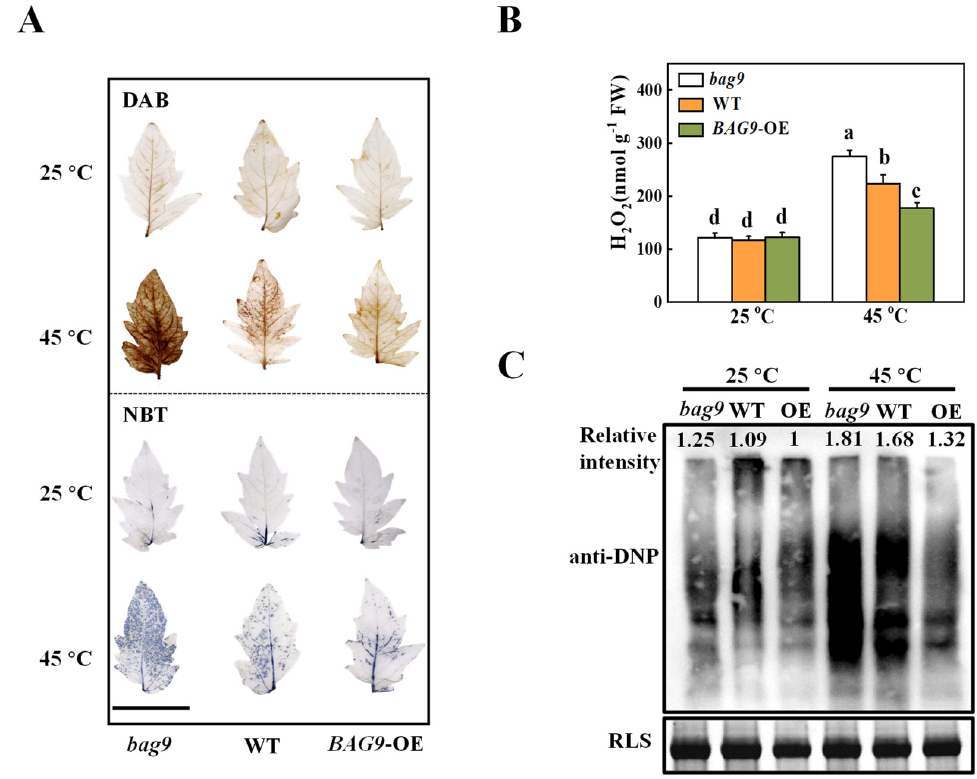
Figure 4. The accumulation of reactive oxygen species (ROS) and oxidative proteins in tomato plants under heat stress. ( A ) Representative images of H 2 O 2 and O 2• − accumulation were detected by DAB and NBT staining, respectively. Bar = 5 cm. ( B ) Quantification of H 2 O 2 at 7 h under heat. ( C ) Oxidative proteins. An anti-DNP antibody was used to detect total proteins on SDS-PAGE. Coomassie Blue staining (CBB) was applied to indicate the protein input, and on the top of the image was the relative intensity of oxidative proteins. Three independent experiments were performed with similar results. Data were the means ±SD of three biological replicates. Different letters represented significant differences ( p < 0.05) according to Tukey’s test. WT, wild type; BAG9 -OE, BAG9 overexpressing plants; RLS, Rubisco large subunit.